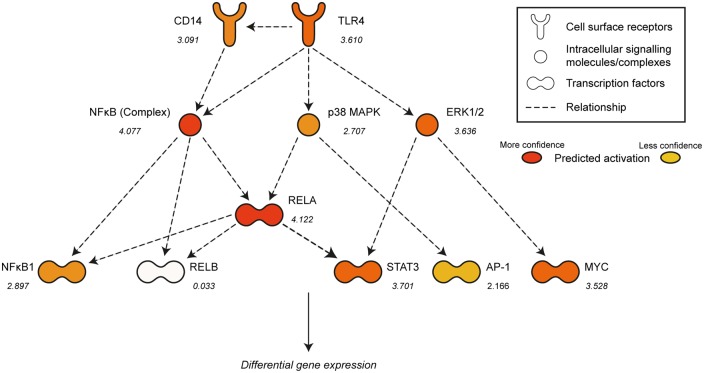
Specific intracellular signalling pathways are predicted to be abnormally activated in resting HD monocytes. IPA analysis of upstream regulators of gene transcription identified numerous signalling pathway components downstream of the TLR4 receptor which are predicted to be abnormally activated in resting HD monocytes. Upstream regulators with significantly inferred activation are shown in orange (darker colour = higher activation z-score). The activation z-score for each component is also shown (>2 or < −2 is considered to be significant).